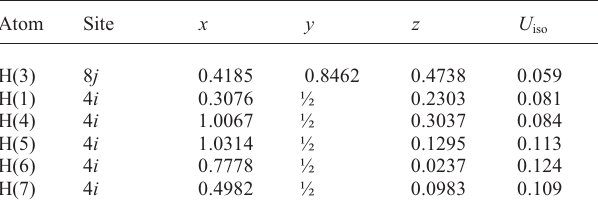
Table 2. Atomic coordinates and displacement parameters (in Å 2 )